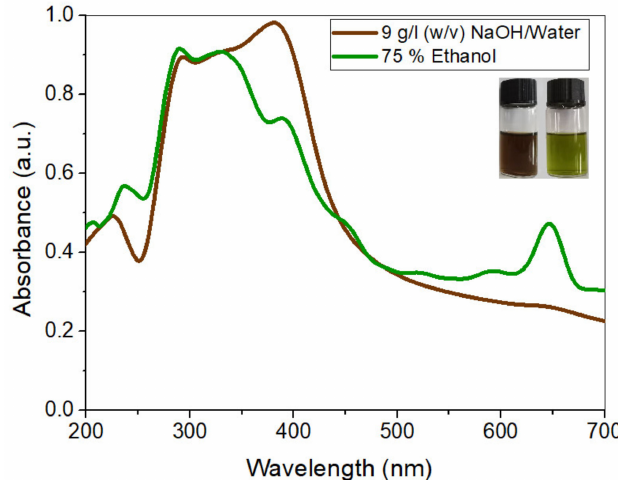
Figure 5. UV-Vis spectrum of optimized extracts.